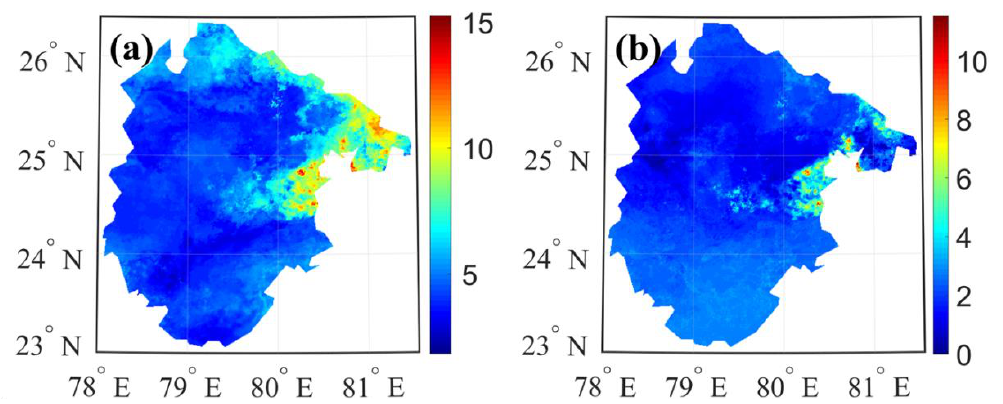
Figure 14. Drought duration maps for historic observed data for study area BK. ( a ) for severe drought and ( b ) for extreme drought. The scale bar represents months of drought in historic 30 years (1985 – 2014).